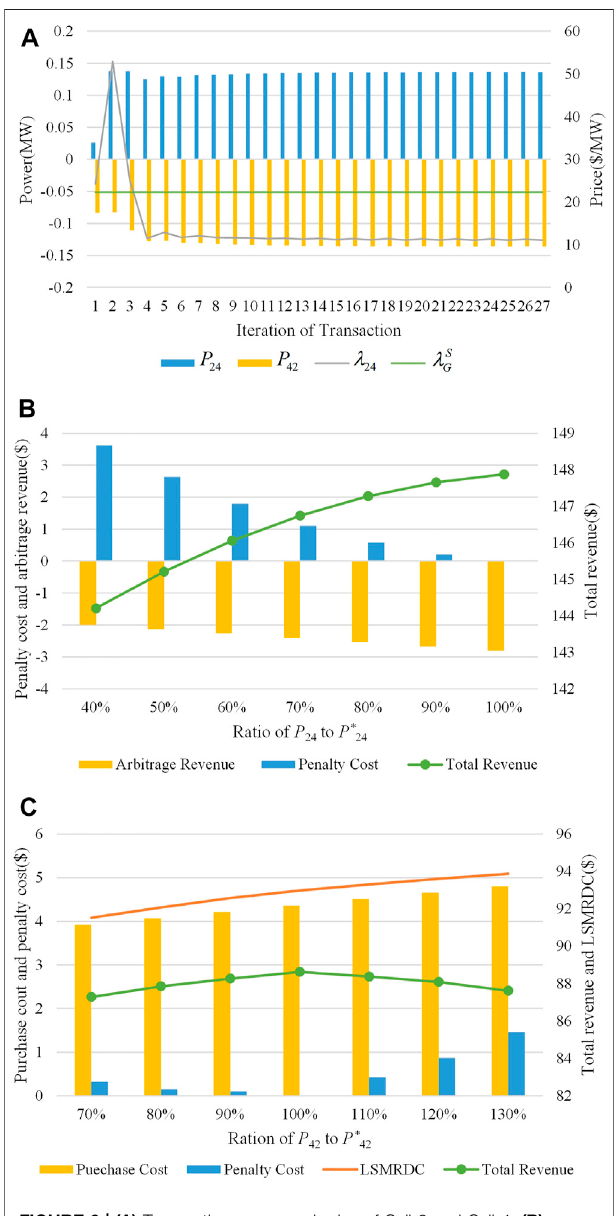
FIGURE 9 | (A) Transaction power and price of Cell-2 and Cell-4. (B) TotalrevenueofCell-2sellingdifferentlevelpowerinthe4thiteration. (C) Total revenue of Cell-4 purchasing different level power in the 4 th